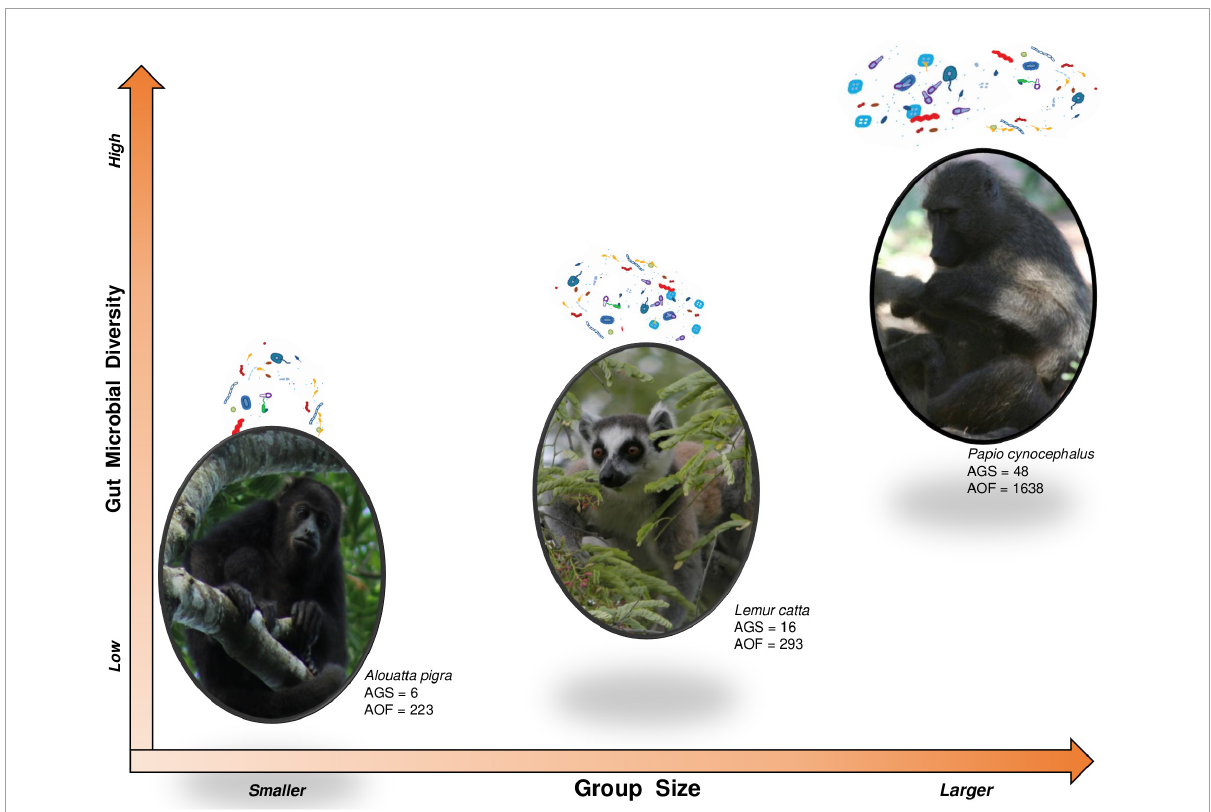
FIGURE1 From ecology metacommunity theory, individuals serve as microbial patches pooling into the social microbiome. Therefore, we expect higher microbial diversity in larger groups, in turn limited by demographic processes, hosts’ properties, and environmental constraints. Furthermore, microbial similarity would be higher between individuals forming a stable, close and preferential association. Comparing data published for howler monkeys— Alouatta pigra (Amato et al., 2017) (credit: COBIUS AC – Image Database), ring-tailed lemurs— Lemur catta (Bennett et al., 2016) (credit: Frank Vassen, CC BY 2.0), and yellow baboons— Papio cynocephalus (Grieneisen et al., 2017) (credit: Augusto J. Montiel Castro), we observe a trend in microbial diversity (measured as average observed features—AOF) with regards to group size (average group